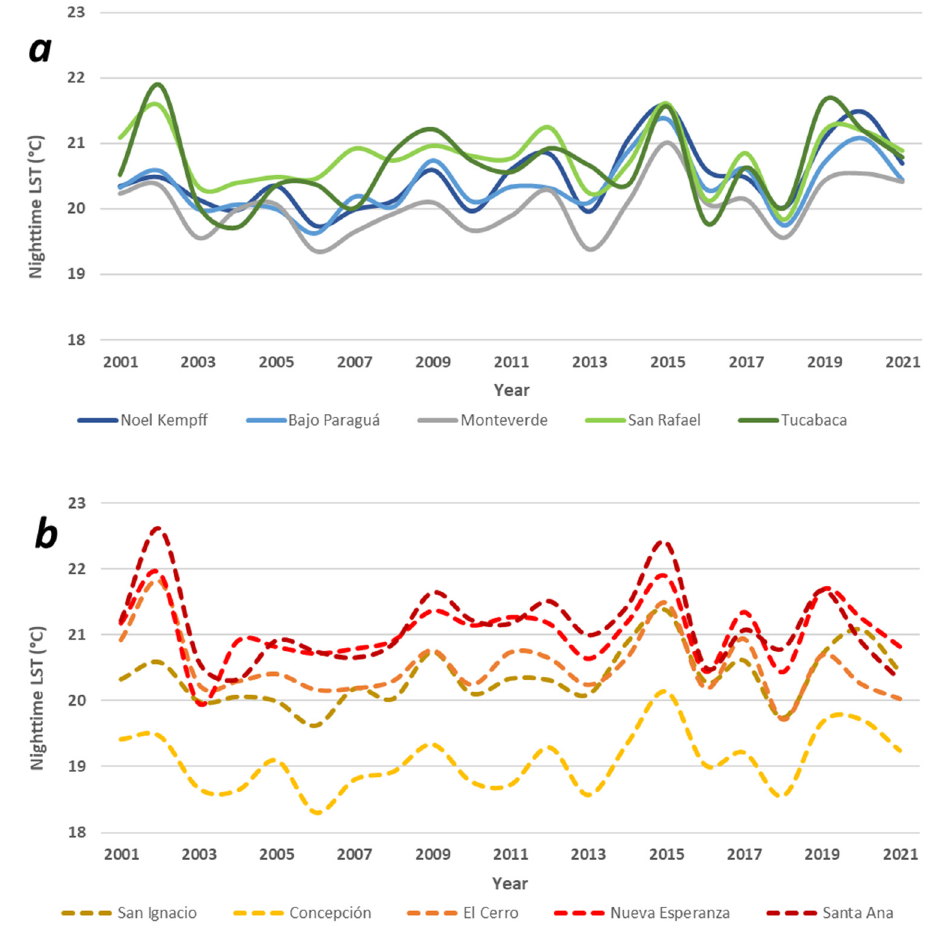
Figure 7. Average annual nighttime LST ( ◦ C) in forested ( a ) and deforested ( b ) areas in the Chiquitania region (2001–2021). Table 4. Nighttime LST trends ( ◦ C) for ten Chiquitania study sites. n—MODIS data